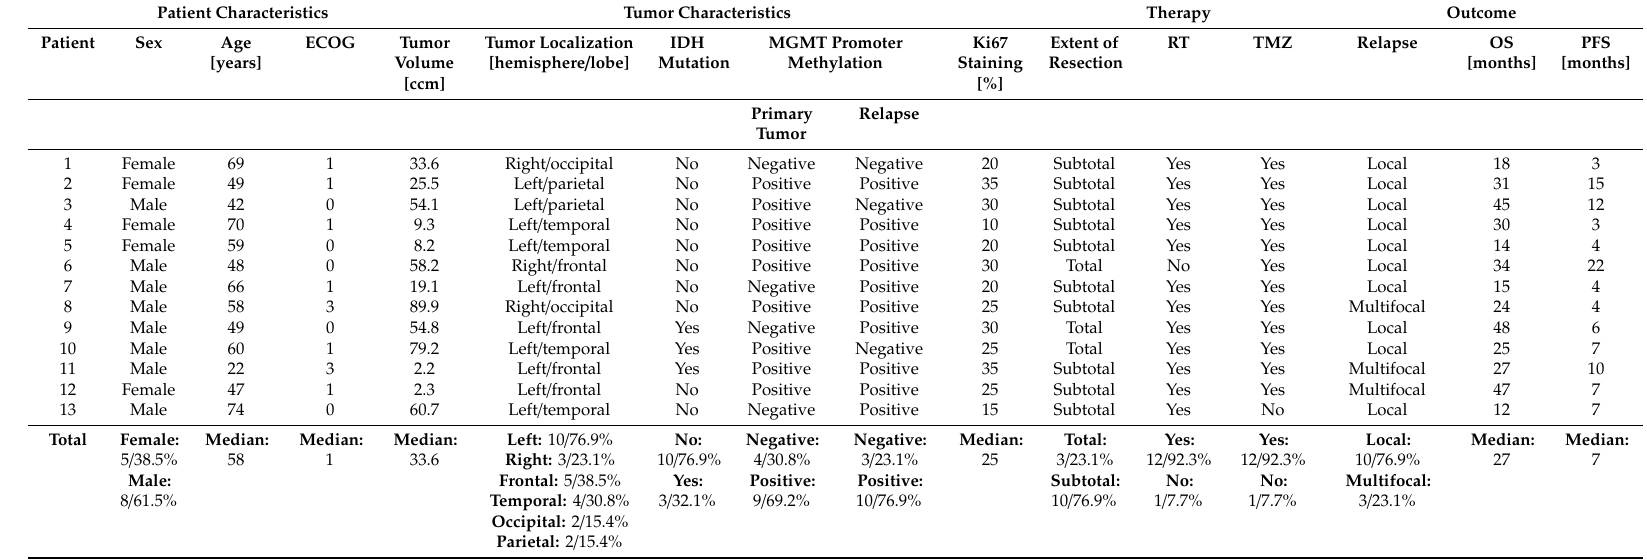
Table 1. Summary of patients’ clinical